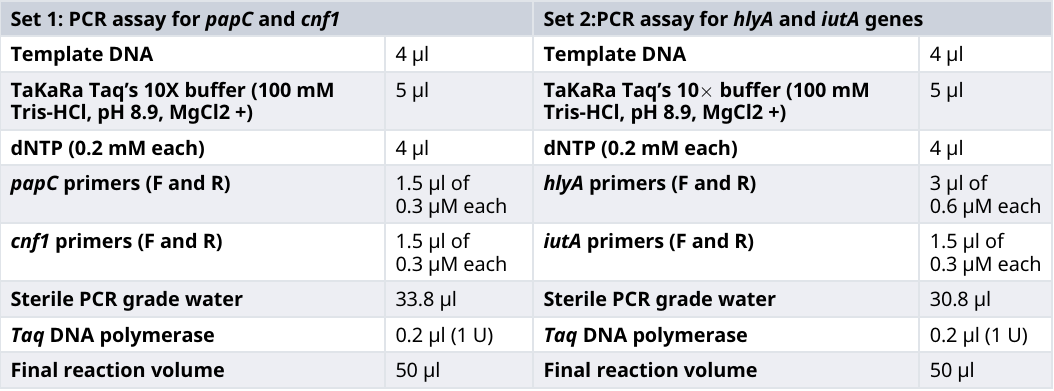
Table 1. PCR mastermix preparation for set 1 and set 2 of multiplex PCR. Set 1: PCR assay for papC and cnf1 Set 2:PCR assay for hlyA and iutA